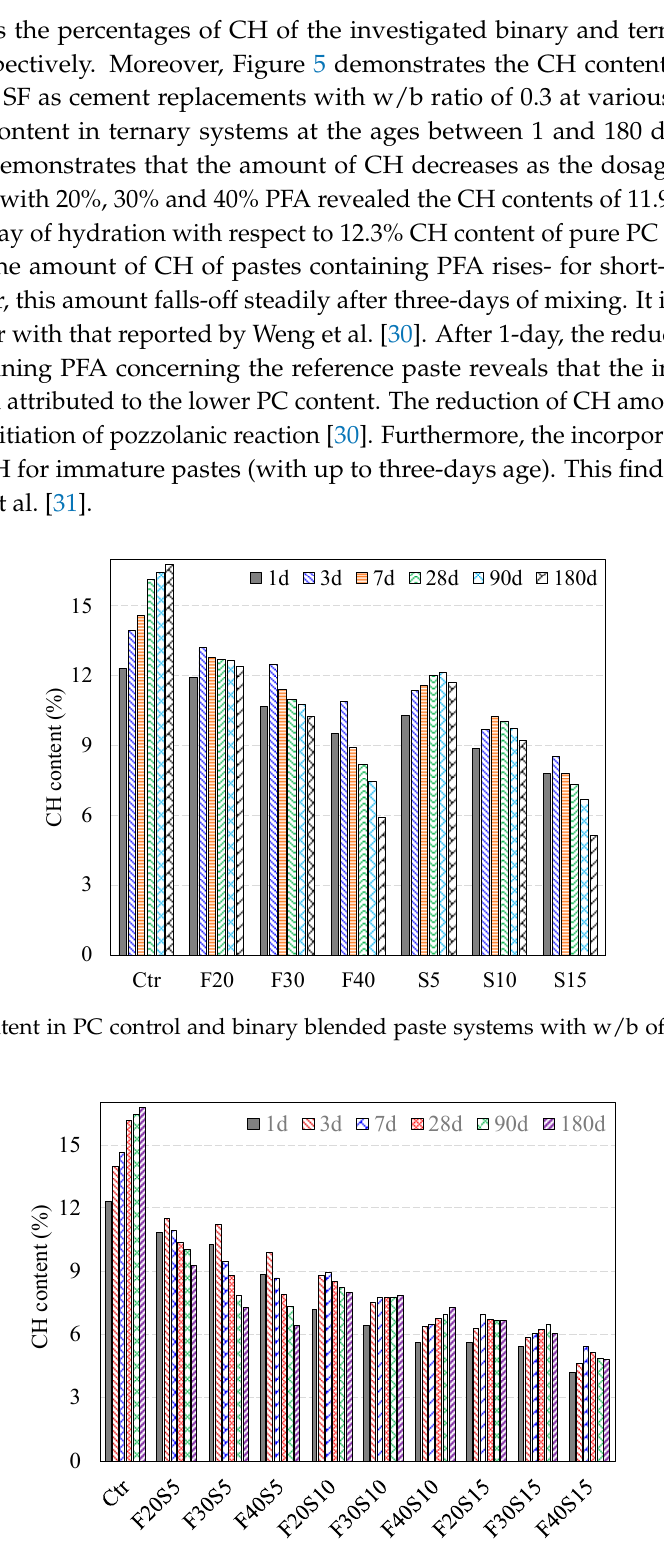
Figure 6. CH content in PC control and ternary blended paste systems with w/b ratio 0.3, mist cured, at various